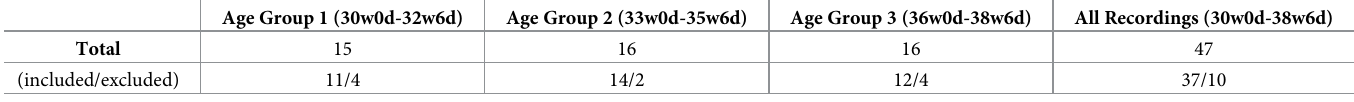
Table 1. Distribution between gestational age